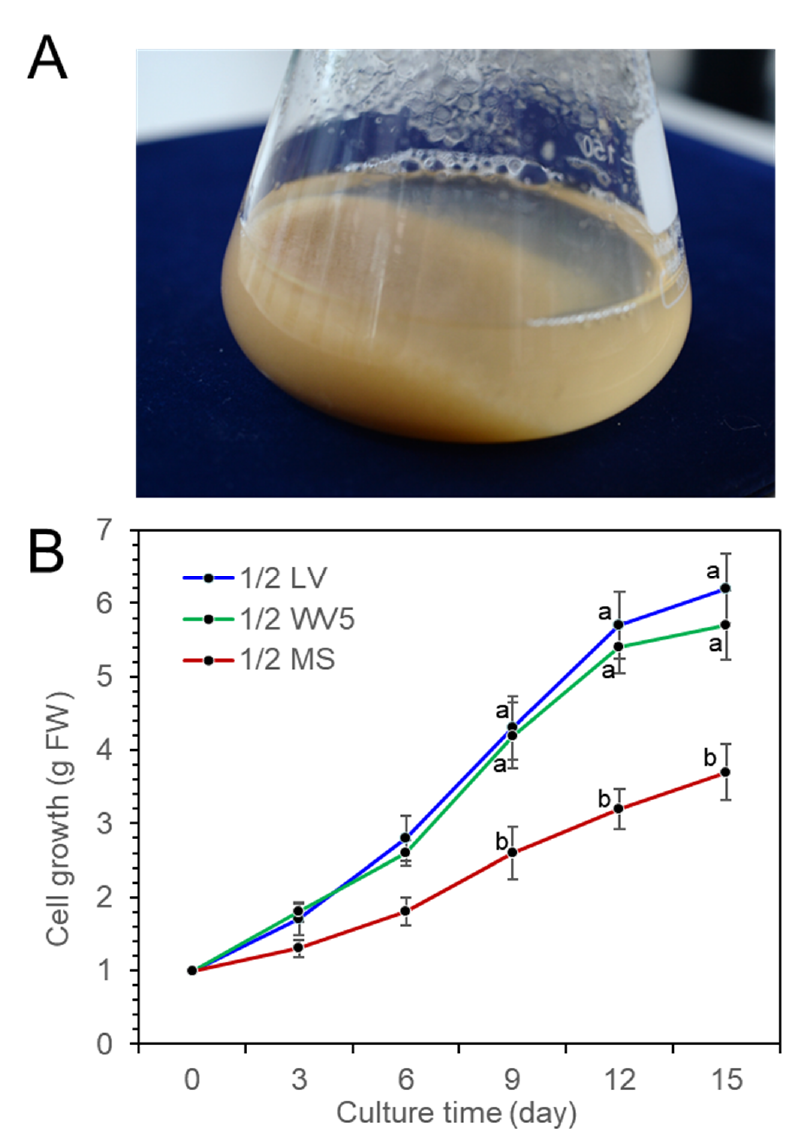
Figure 3. Proliferation of P. koraiensis cells in three different media (1/2 LV, 1.2 WV5, and 1/2 MS) containing 2.2 µM 2,4-D with 2.2 µM BA after 15 days of culture. ( A ) Cell suspension in a 250-ml flask containing 1/2 LV liquid medium with 2.2 µM 2,4-D with 2.2 µM BA after 15 days of culture. ( B ) Growth of cells (fresh weight) in three different media (1/2 LV, 1.2 WV5, and 1/2 MS) containing 2.2 µM 2,4-D and 2.2 µM BA during 15 days of culture. One gram of initial fresh weight of cells was